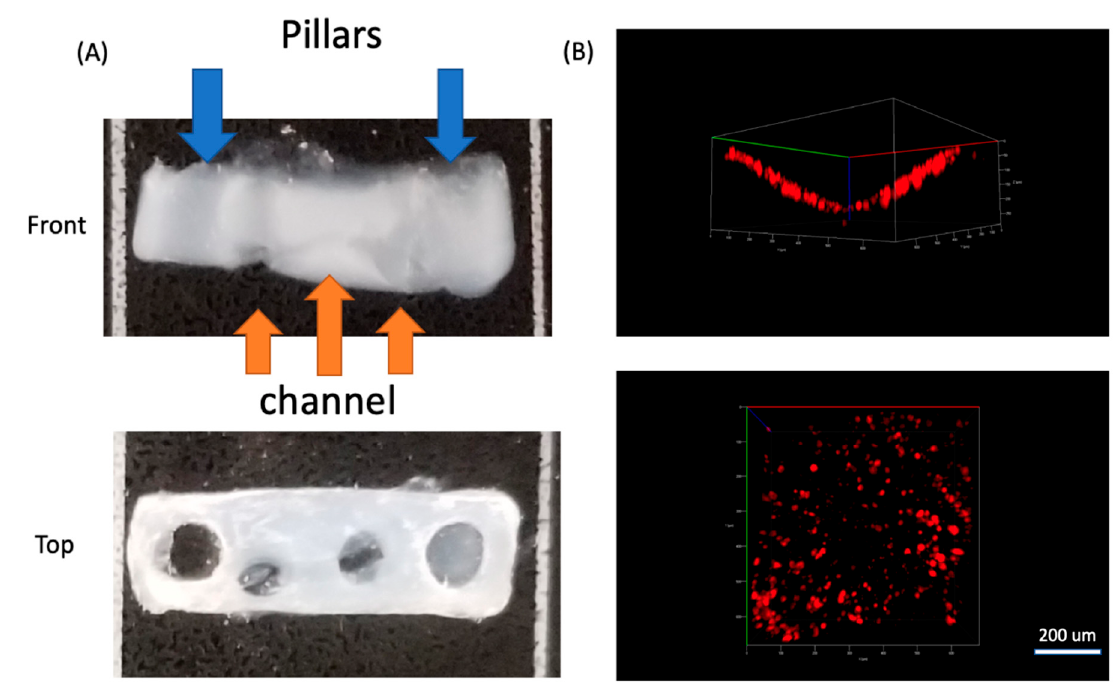
Figure 6. ( A ) Front and top view of the collagen scaffold with pillars and embedded channels. ( B ) Front and top view of HUVEC cells stained with CellTracker DeepRed cultured in the channel and imaged using confocal microscopy.